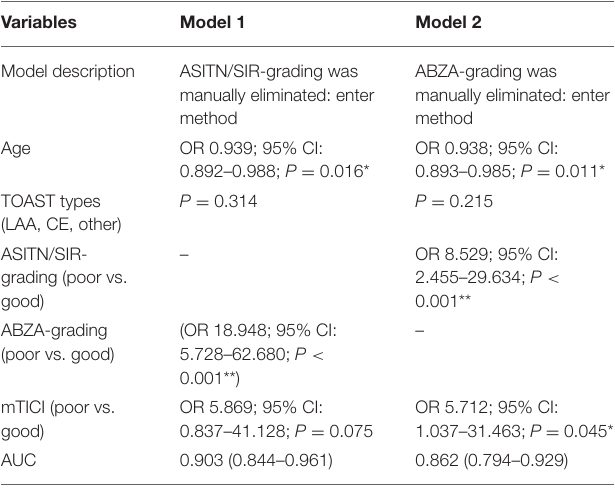
TABLE 3 | Logistic regression analysis of the 90-day-outcome predictors in MCAO patients after